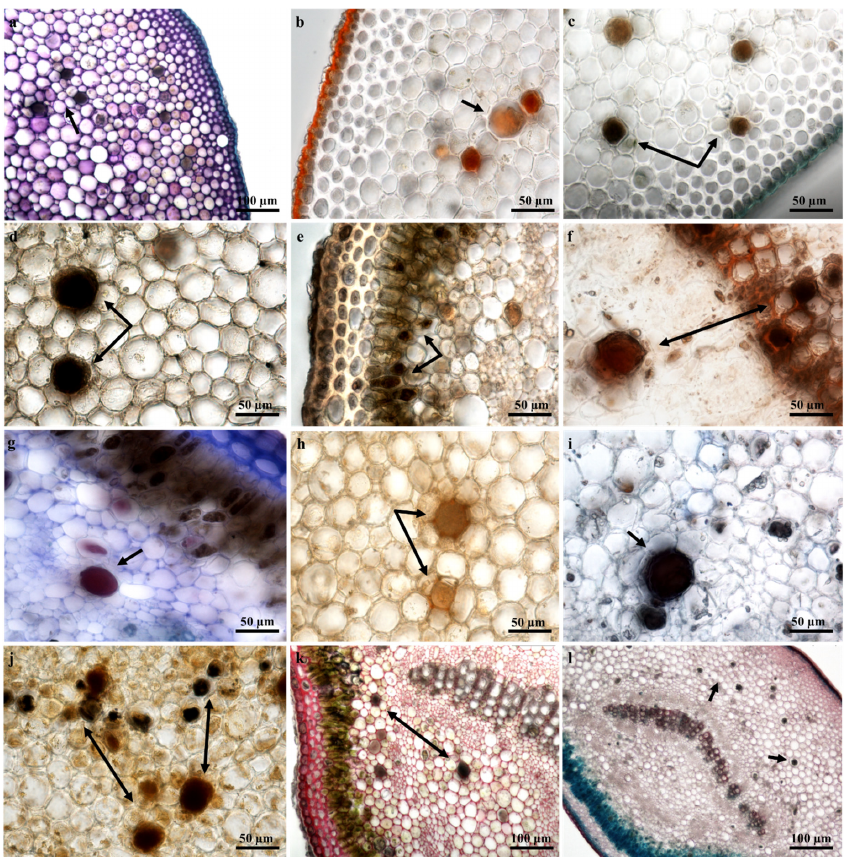
Figure 7. Histochemical observations of laticifers in young leaf midrib sections of T. ventricosa . ( a ) Presence of polysaccharides within laticifer cells stained using Toluidine Blue. ( b ) Positive staining of lipids within laticifers using Sudan IV. ( c ) Negative staining of lipids, cutin, and suberized cell walls of laticifers using Sudan black B. ( d ) Ferric Trichloride positively stained laticifers a dark-black color. ( e ) Presence of phenolics within laticifer cells stained using Ferric Chloride. ( f ) Intense staining of resin acids within laticifers using NADI reagent. ( g ) Intense staining of neutral lipids within laticifers using Nile Blue. ( h ) Negative staining of lignin aldehydes within laticifer and cell components stained using Phloroglucinol. ( i ) Intense blue-black staining of proteins in laticifers. ( j ) Intense staining of alkaloids within laticifers stained using Wagner’s and Dittmar’s reagent. ( k ) Positive staining of mucilage and pectin using Ruthenium Red. ( l ) Presence of acidic substances in laticifers stained using Safranin and Fast Green. Arrows refer to laticifer.